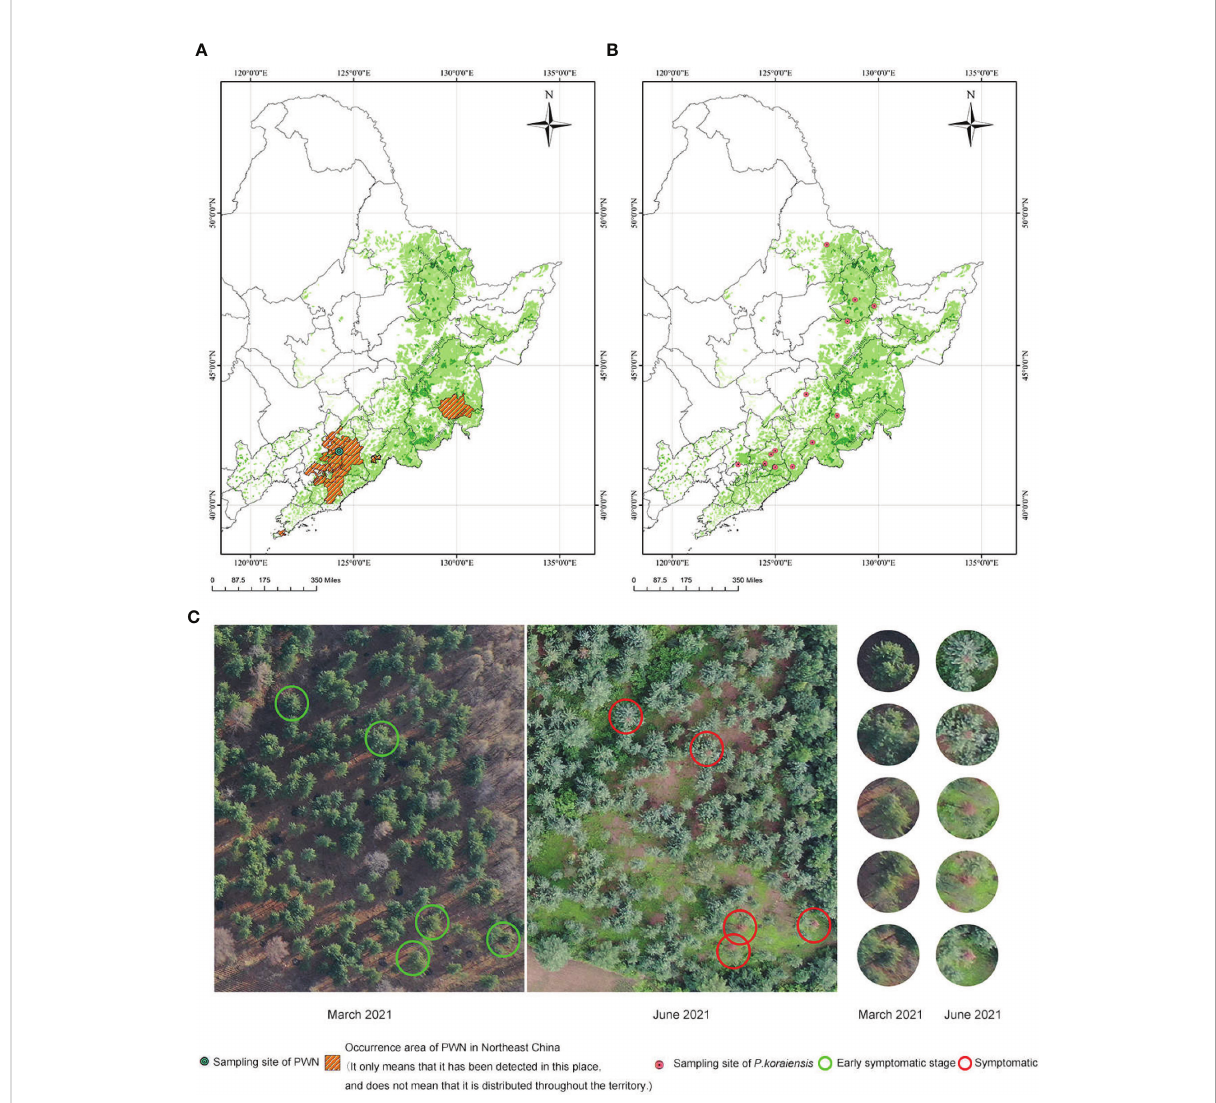
FIGURE 1 Distribution of the collected samples and unmanned aerial vehicle-collected images of the PWN sampling site. (A) Occurrence and sampling sites of PWN in Northeast China (Data source: up to March 2022). The basemap is the color English version of the map of China (including POI) in ArcGIS. (B) P. koraiensis sampling sites in the experiment (C) Over-year death of P. koraiensis in the PWN sampling area (In 2020, P. koraiensis trees in this area were infected with PWN through M. saltuarius . In March 2021, some P. koraiensis trees in the area showed initial symptoms. In June 2021, P. koraiensis trees that were infected by PWN were completely